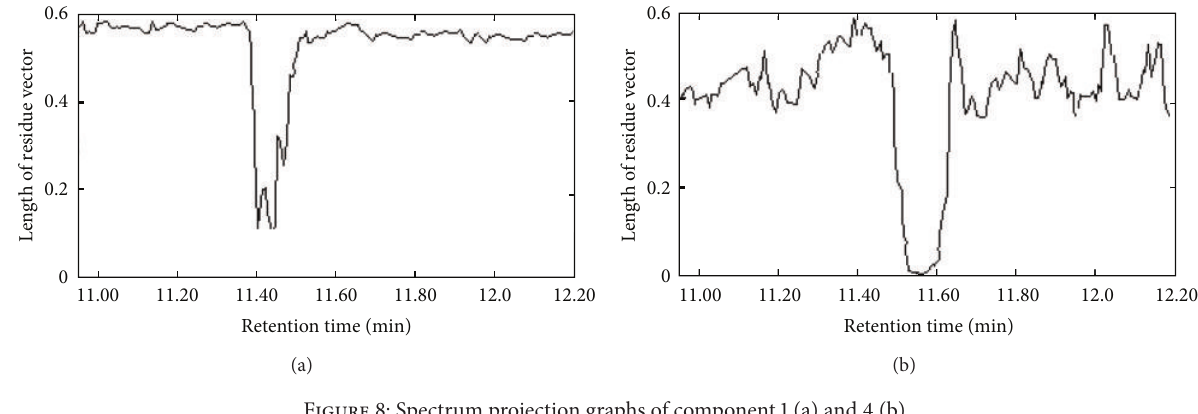
Figure 8: Spectrum projection graphs of component 1 (a) and 4 (b). Table 2: Qualitative results of some other volatile chemical constituents in leaf of Agrimonia eupatoria. Series